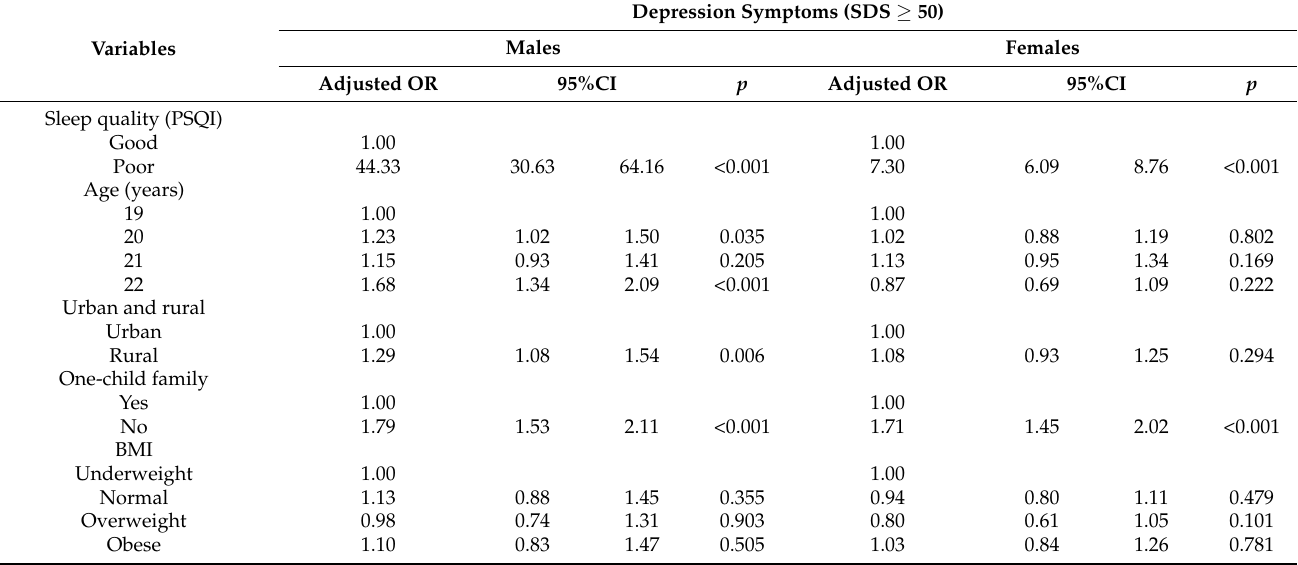
Table 2. The odds ratio of depressive symptoms for different variables by